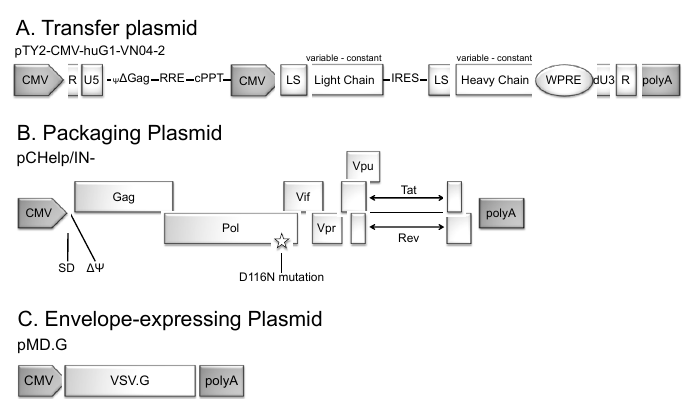
Figure 1. Schematic representation of lentiviral plasmids. ( A ). The lentiviral transfer plasmid pTY2-CMV-huG1-VN04-2 expresses VN04-2 mAbs directed against the H5 hemagglutinin (HA) of influenza A virus (IAV); ( B ). The packaging plasmid contains all necessary packaging elements and the D116N integrase-inactivating mutation; ( C ). The plasmid expressing the envelope protein of VSV-G for pseudotyping.